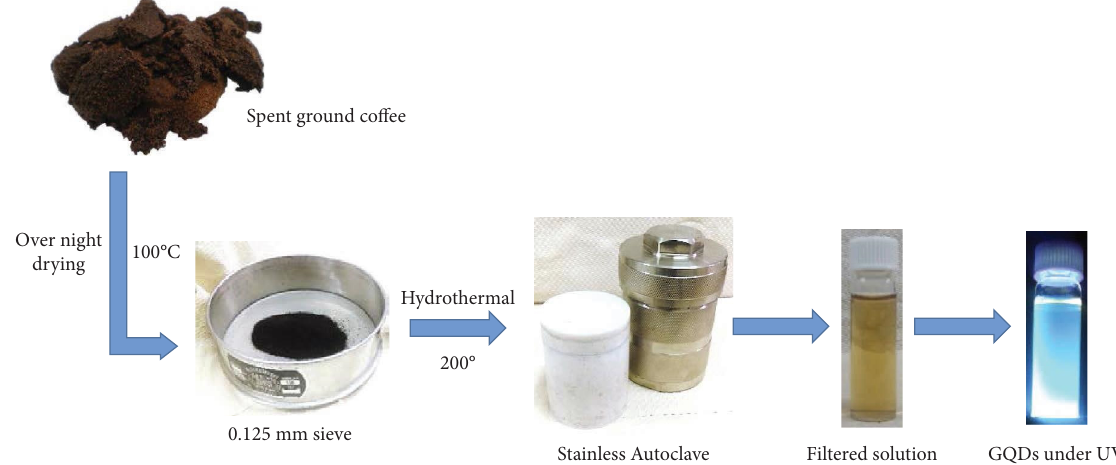
Figure 1: Schematic representation of GQDs and BGQDs synthesis of SCG.